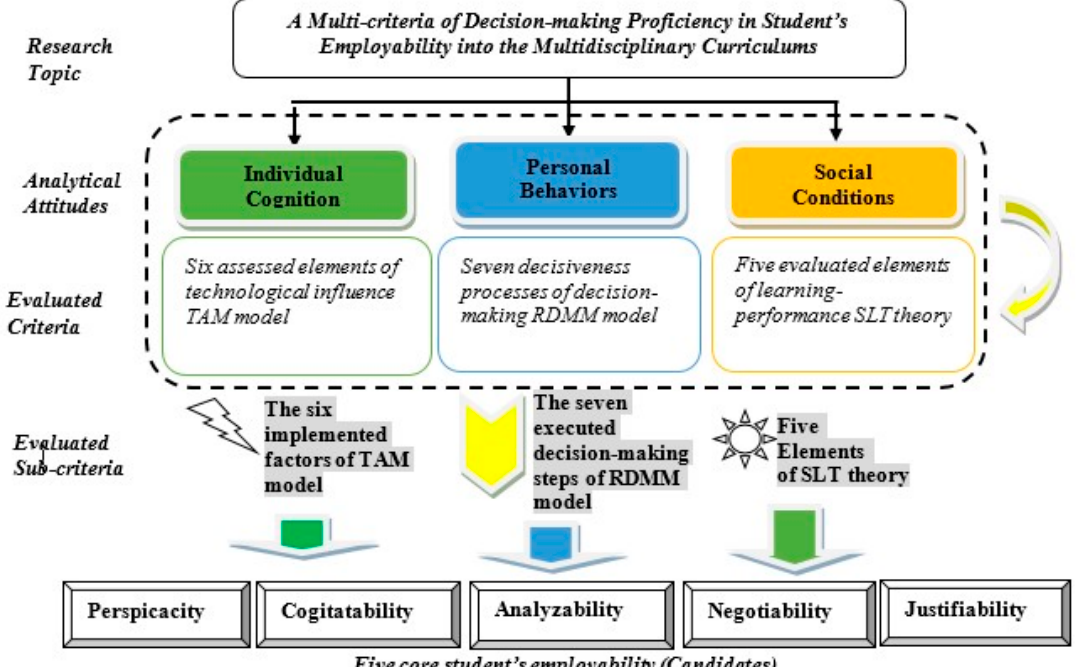
Figure 5. Research design framework.